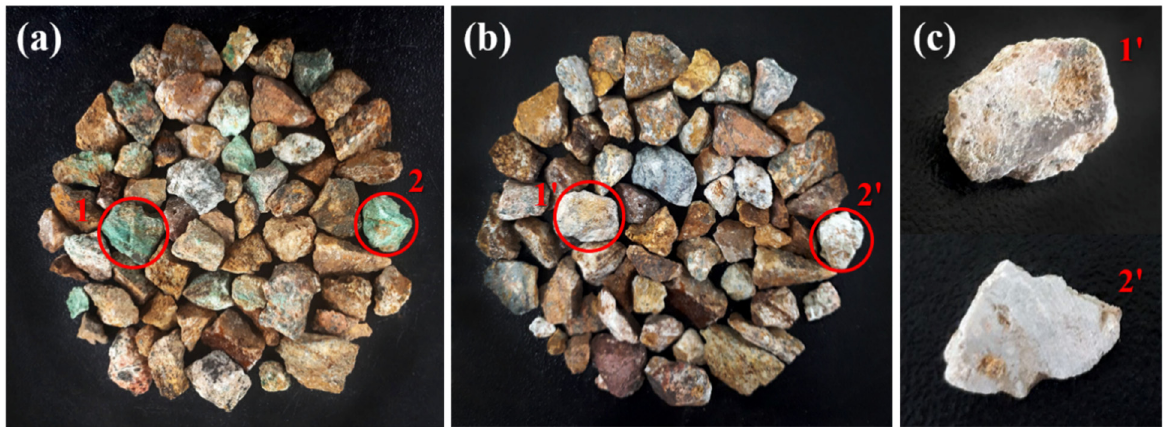
Figure 5. Photographs of raw ore ( a ), sulfuric acid (H 2 SO 4 , 0.15 M)-treated ore ( b ) (after a weeklong, 7 days experiment), and cross-section of leached ore ( c ) (1, 2: ore containing malachite before reaction; 1 ′ , 2 ′ : ore after malachite leaching reac- tion).